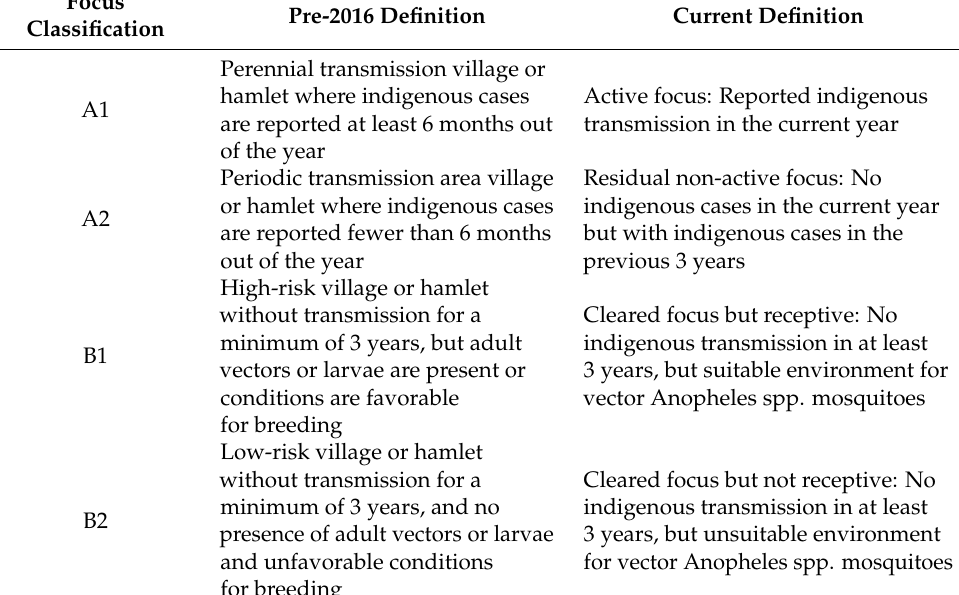
Table 1. Focus classification in